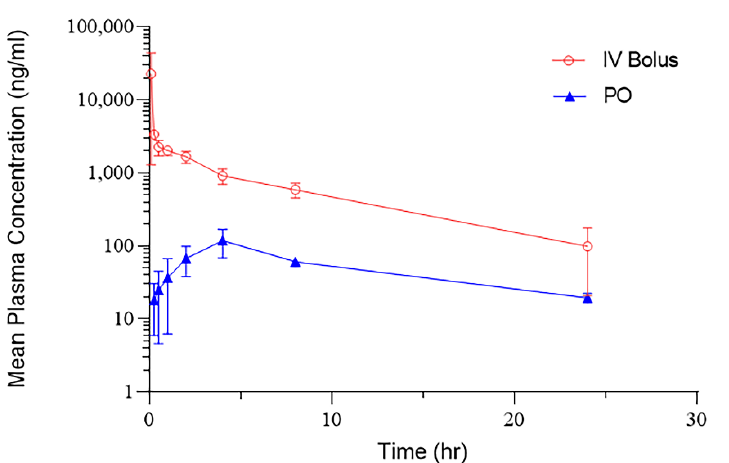
Figure 2. Pharmacokinetics of NBD-14189 in the Rat model. NBD-14189 was dosed by IV bolus or PO administration at 10 mg/kg, and the concentration of the compound in plasma was determined at the indicated time points. Table 1. Summary of pharmacokinetics parameters following a single IV bolus or PO administration of NBD-14189 in Rats.